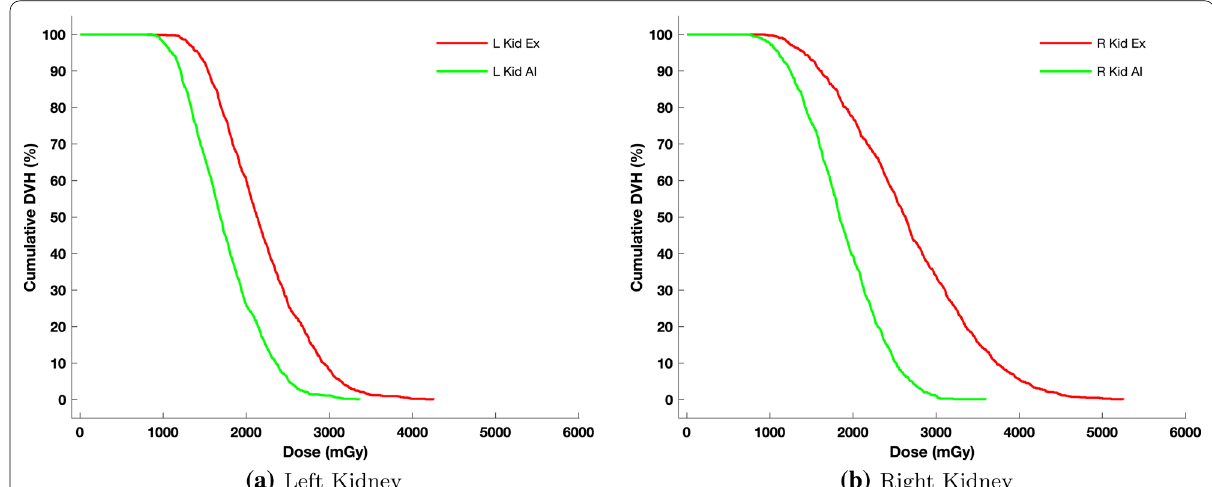
Fig. 4 Dose volume histograms of left and right kidneys for patient 7 with the highest error margin. Red lines represent the dose calculations based on expert segmentation and the green lines represent the corresponding dose based on the AI